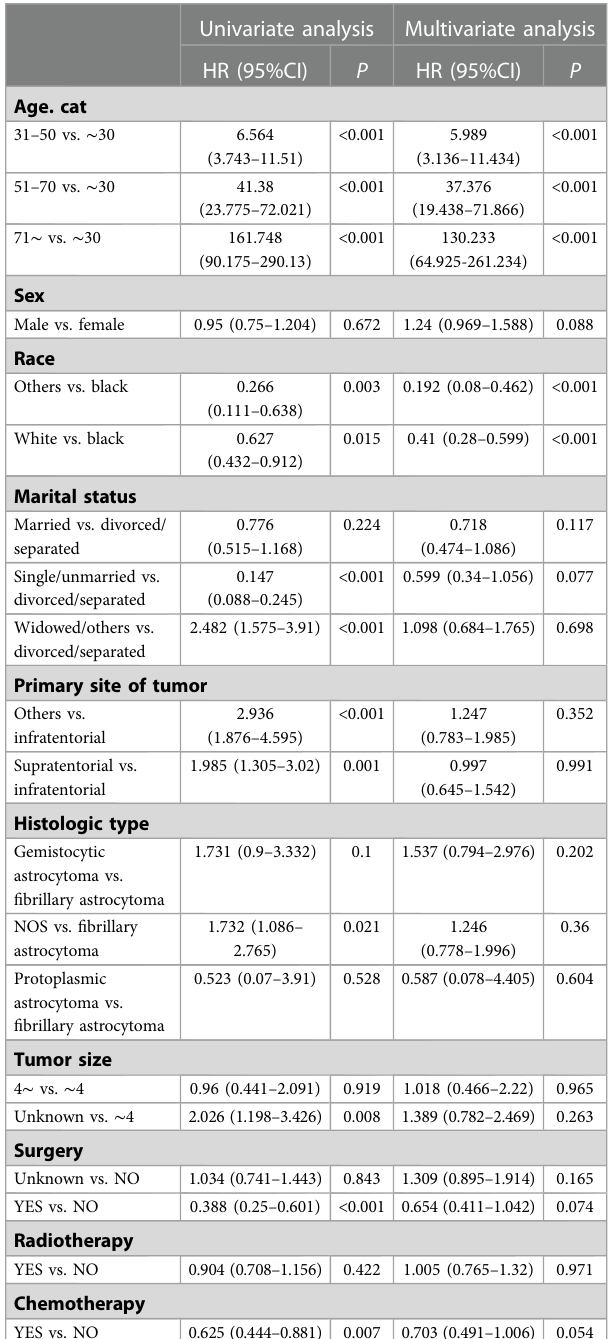
TABLE 2 Univariate and multivariate Cox regression analysis.